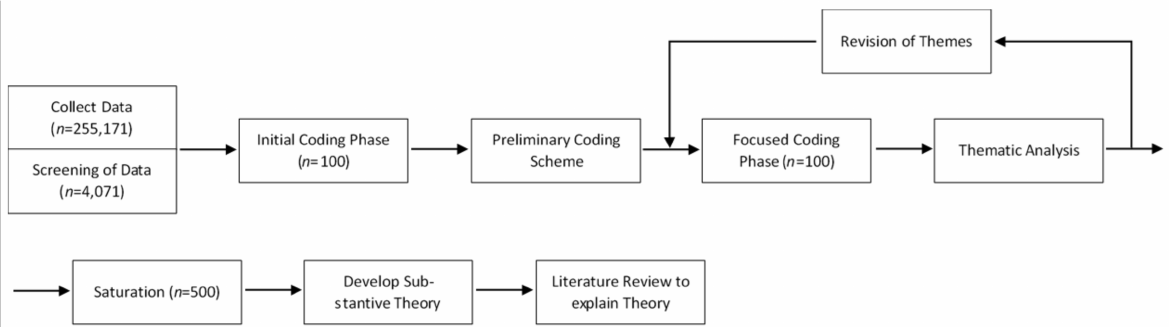
Figure 1. Flowchart of data analysis